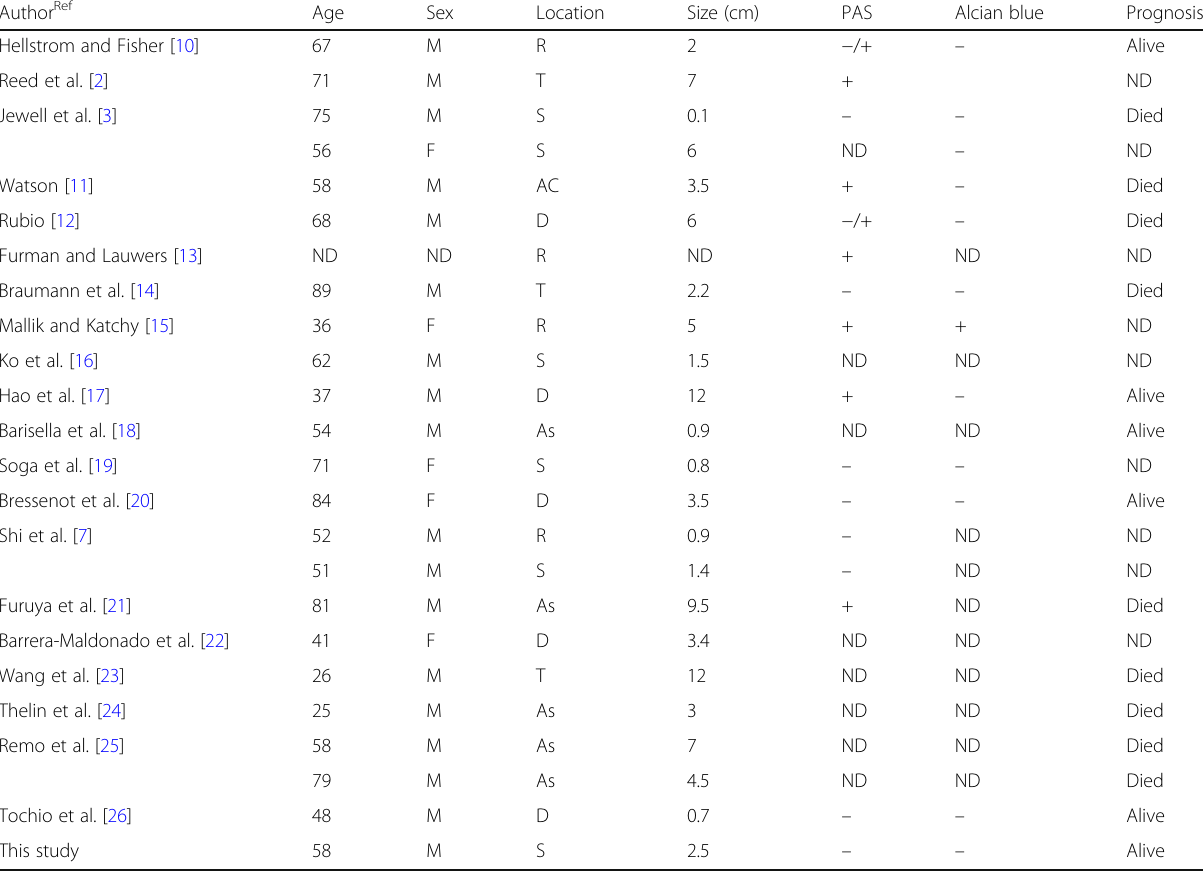
Table 3 Clinicopathological information for 24 colorectal adenocarcinomas with clear cell components Author